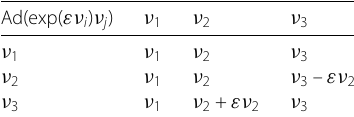
Table 2 Adjoint representation table of Eq.